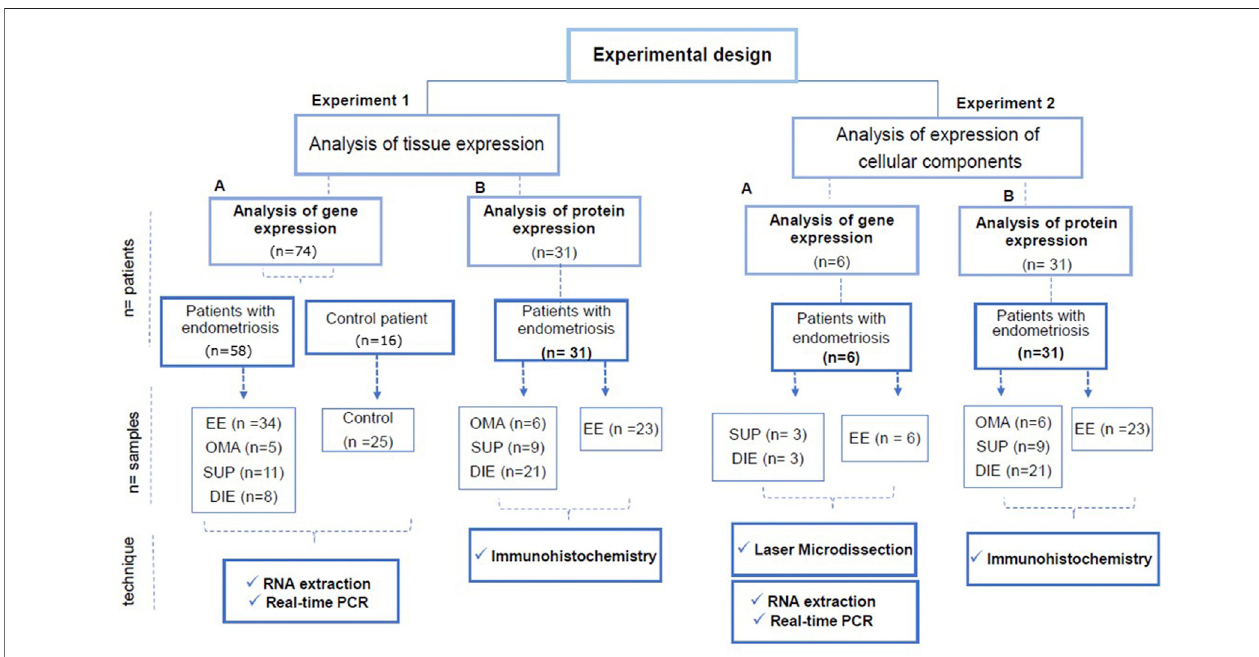
FIGURE1| Experimentaldesignofthestudy.Thestudywascarriedoutintwotypesofexperiments:Experimenttype1:analysisofgeneandproteinexpressionof the estrogen synthesizing enzymes in tissue samples. Experiment type 2: analysis of gene expression of estrogen synthesizing enzymes in microdissected areas containing glandular epithelium or stroma, and the protein expression analysis done by IHC in whole tissue sections. In experiments 1-A and 2-A, the samples were evaluated for gene expression of ARO, STS , and HSD17B1 by RT-PCR. In experiments 1-B and 2-B, the samples were evaluated for protein expression of the enzymes ( ARO, STS , and HSD17B1 ) by immunohistochemistry (IHC). In experiment 1-A, samples from 83 (endometriosis and control) were analyzed. Fifty-eight endometriosis patients provided 34 samples of eutopic endometrium, 5 ovarian lesions, 11 super fi cial peritoneal lesions, and 8 deep lesions. Samples from 16 control patients provided 25 biopsies of the endometrium. Some control patients provided samples from both menstrual cycle phases. In experiment 1-B, samples from six endometriosis patients were used, three of which were from super fi cial peritoneal lesions, three were from deep lesions, and six samples were from eutopic endometrium. In experiment 2-B, 31 patients provided 6 samples of ovarian lesions, 9 samples of peritoneal super fi cial lesions, 21 samples of deep lesions, and 23 samples of eutopic endometrium. Abbreviations: EE, eutopic endometrium of a patient with endometriosis; control, control endometrium; OMA, ovary endometriotic lesion; SUP, super fi cial peritoneal endometriotic lesion; DIE, deep endometriotic